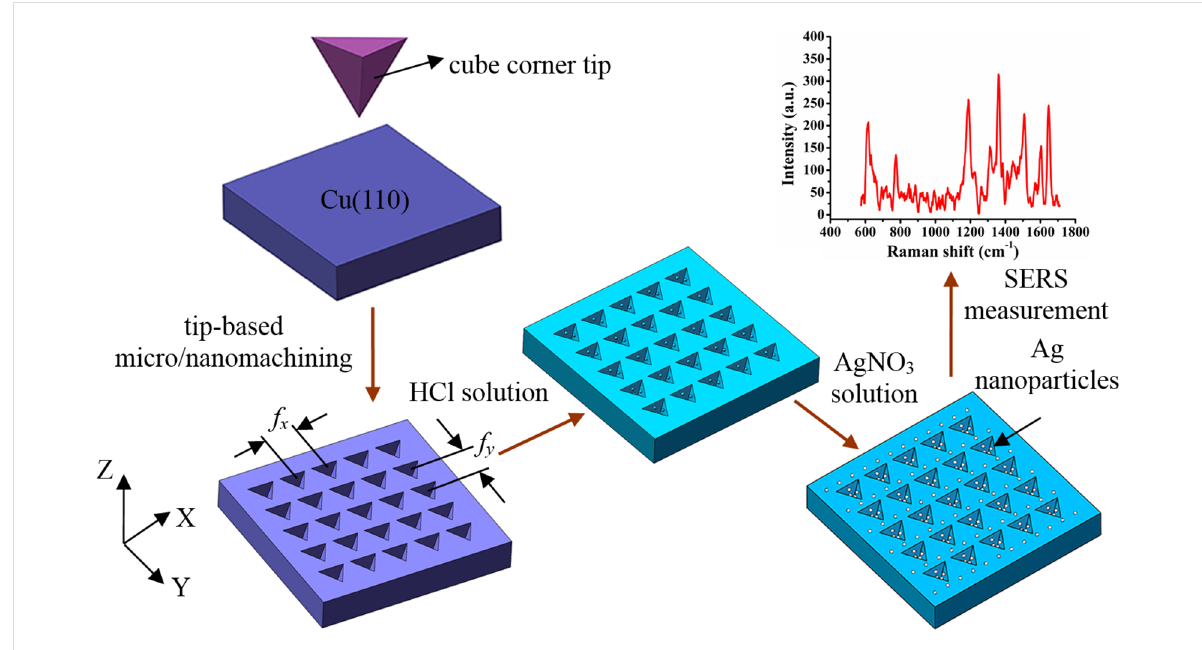
Figure 13: Schematic diagram of the hierarchical SERS substrate with Ag nanoparticles on the arrayed pyramidal cavities.